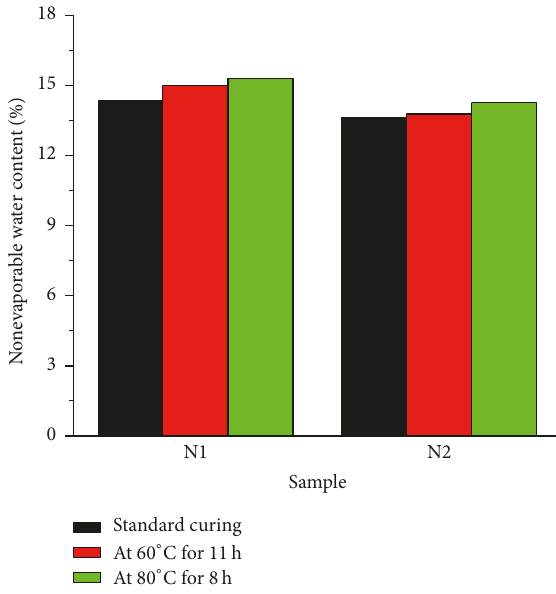
Figure 8: Nonevaporable water contents of the pastes containing phosphorus slag with W/B of 0.4 at the age of demoulding time.